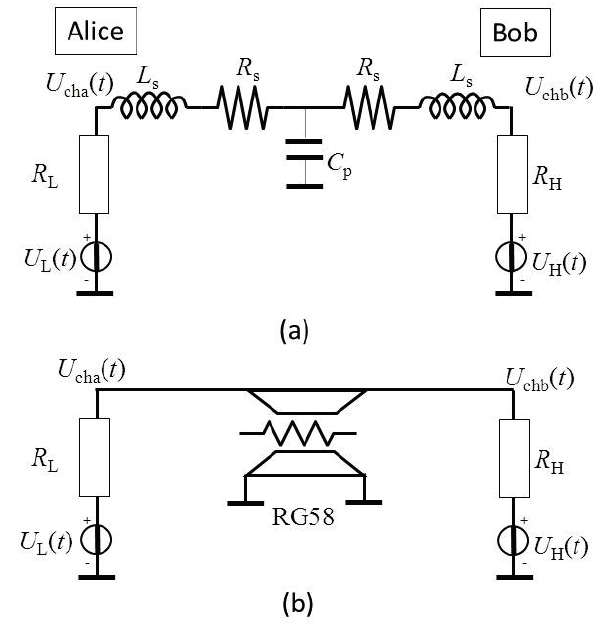
R (1 kohm) and R L H  10.5 ohm S